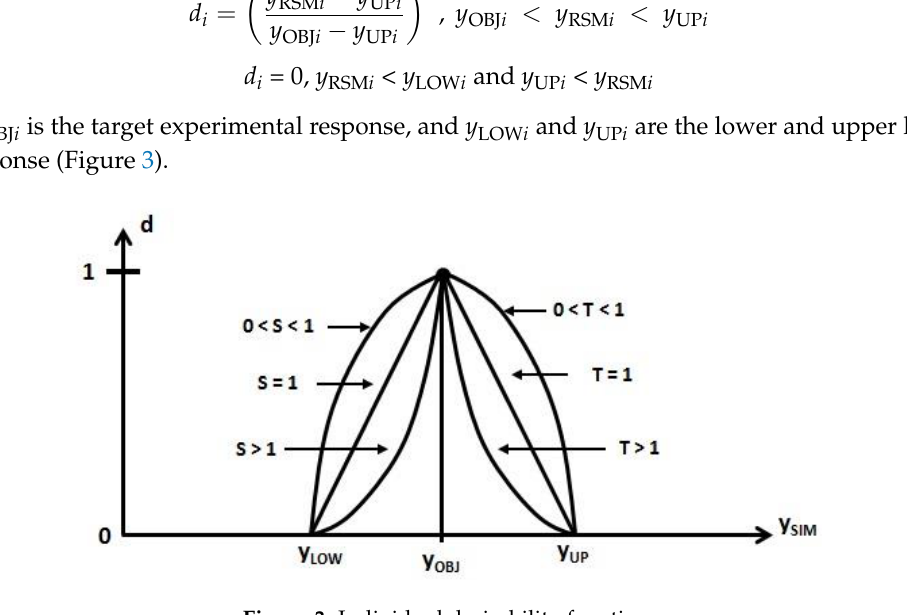
Figure 3. Individual desirability function.